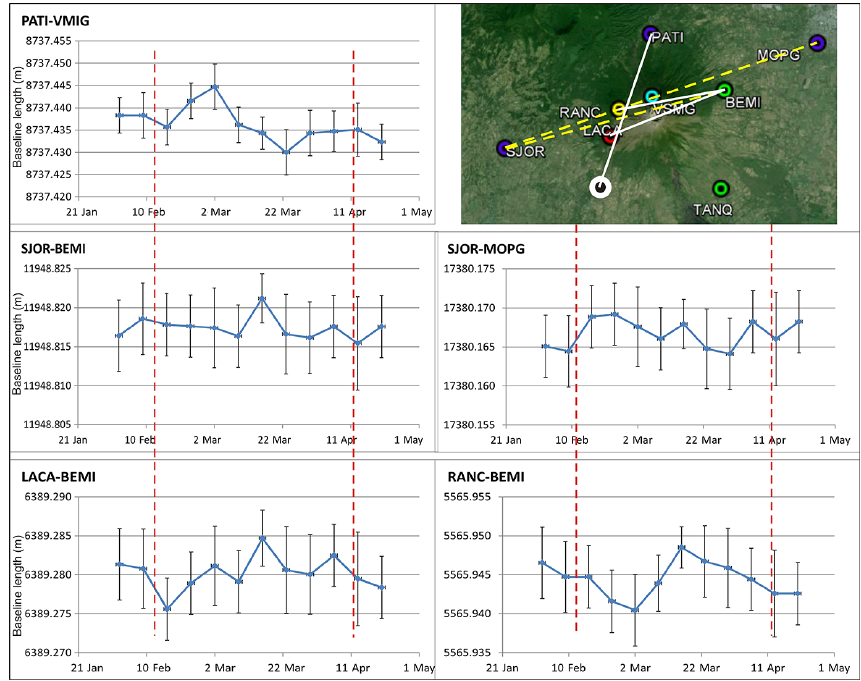
Figure 12. Variations of long length baselines (meters) crossing the volcano. The map shows the location and kinematics of the baselines: white solid lines indicate baselines showing significant fluctuations, yellow dashed lines indicate baselines showing no deformation.